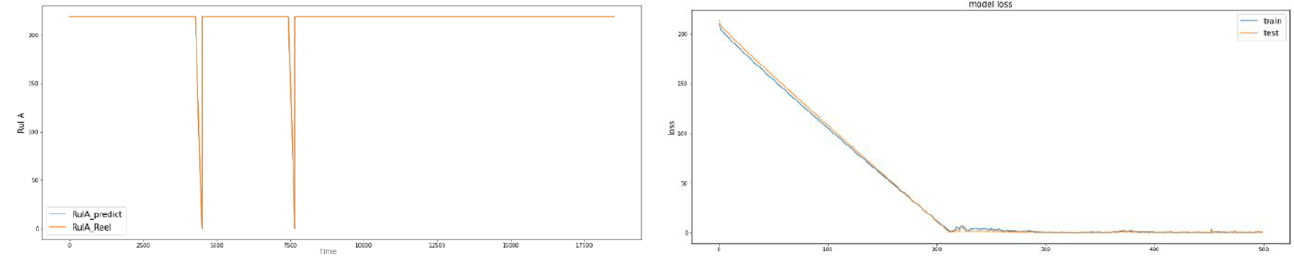
Figure 18. LSTM method for continuous cluster 2 with RULA fixation at 219.